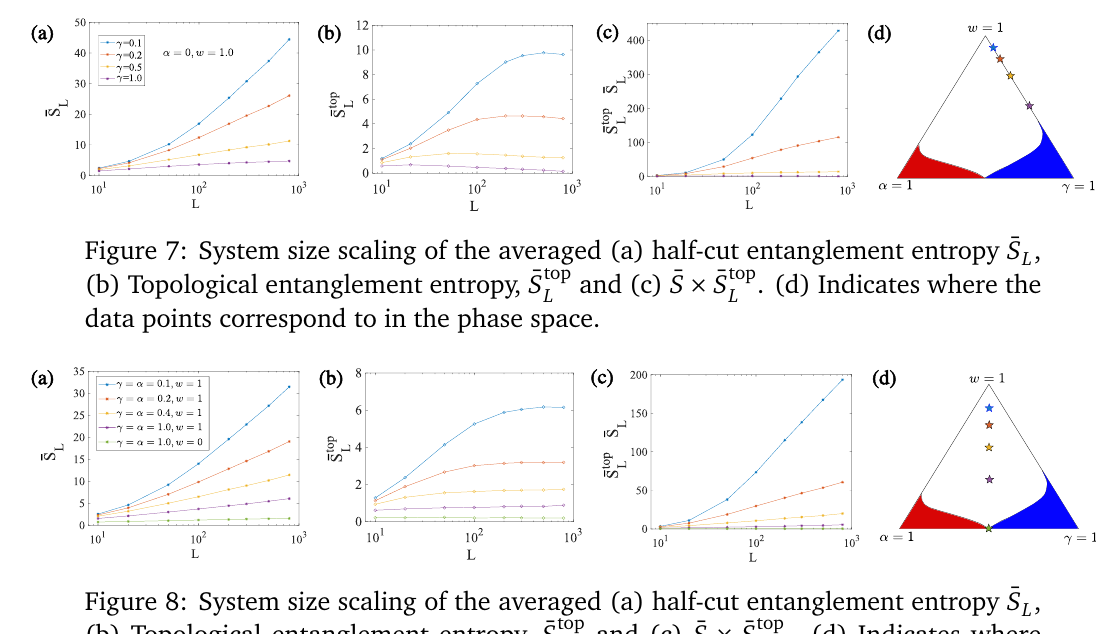
Figure 8: System size scaling of the averaged (a) half-cut entanglement entropy ¯ S (b) Topological entanglement entropy, ¯ S top the data points correspond to in the phase space. The special point at w = 0 shows ≈ 0.19ln L + log-scaling S L